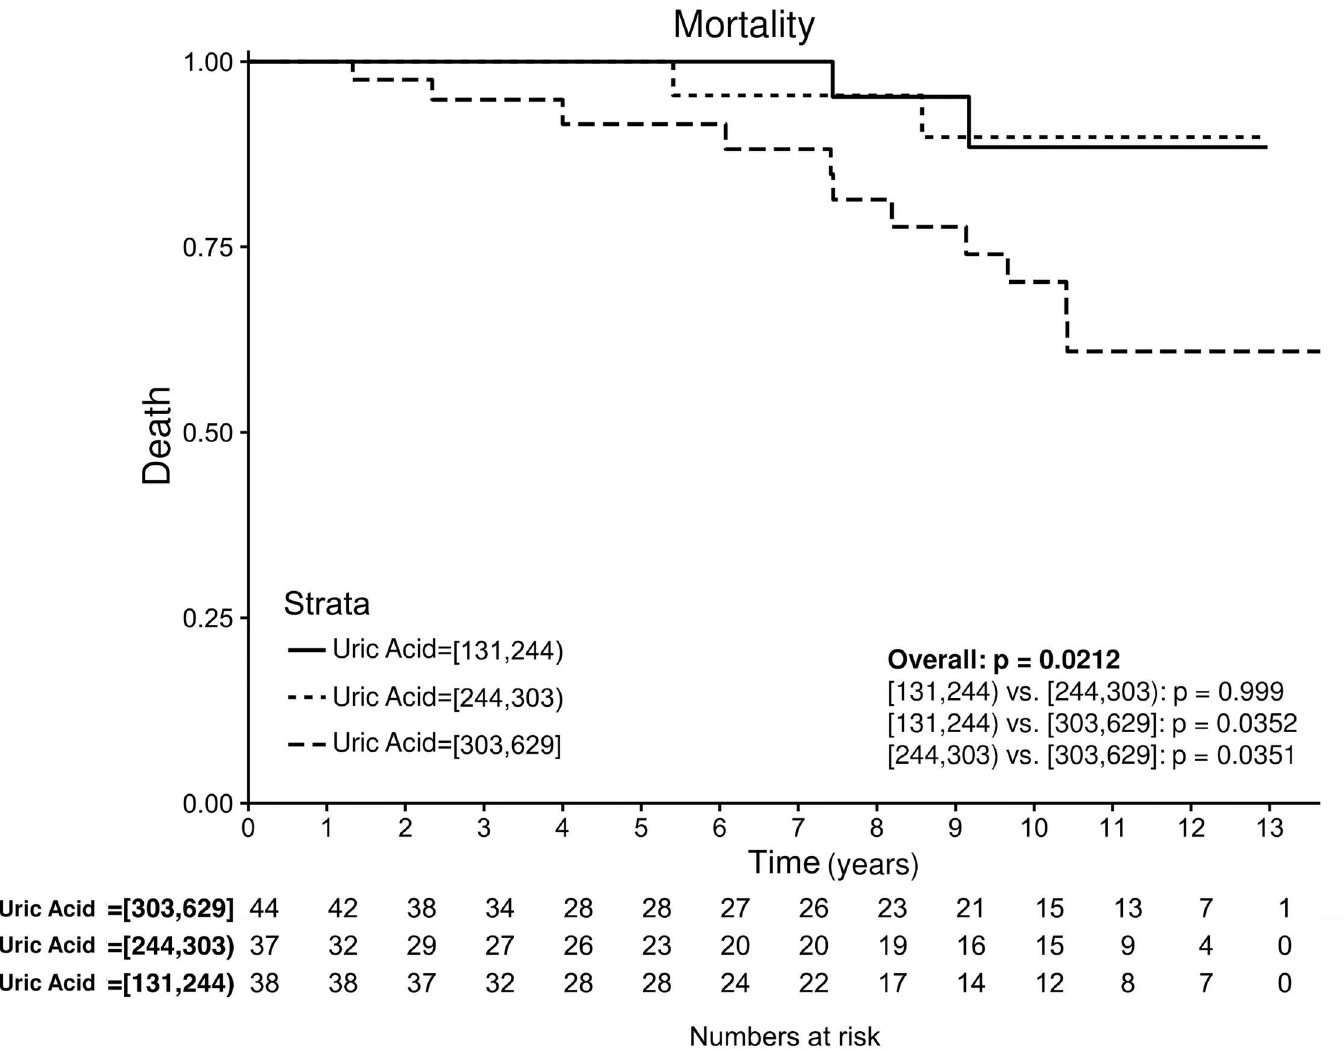
Fig 2. Kaplan-Meier analysis of all-cause mortality according to tertiles of UA. Patients with higherUA levels had significantly UA increasedoverall mortality in univariateanalysis(p = 0.021).